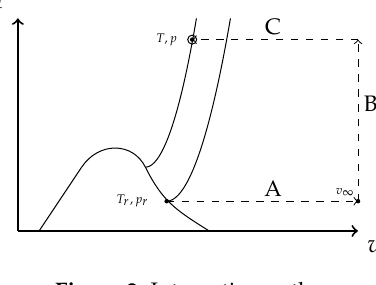
Figure 2. Integration